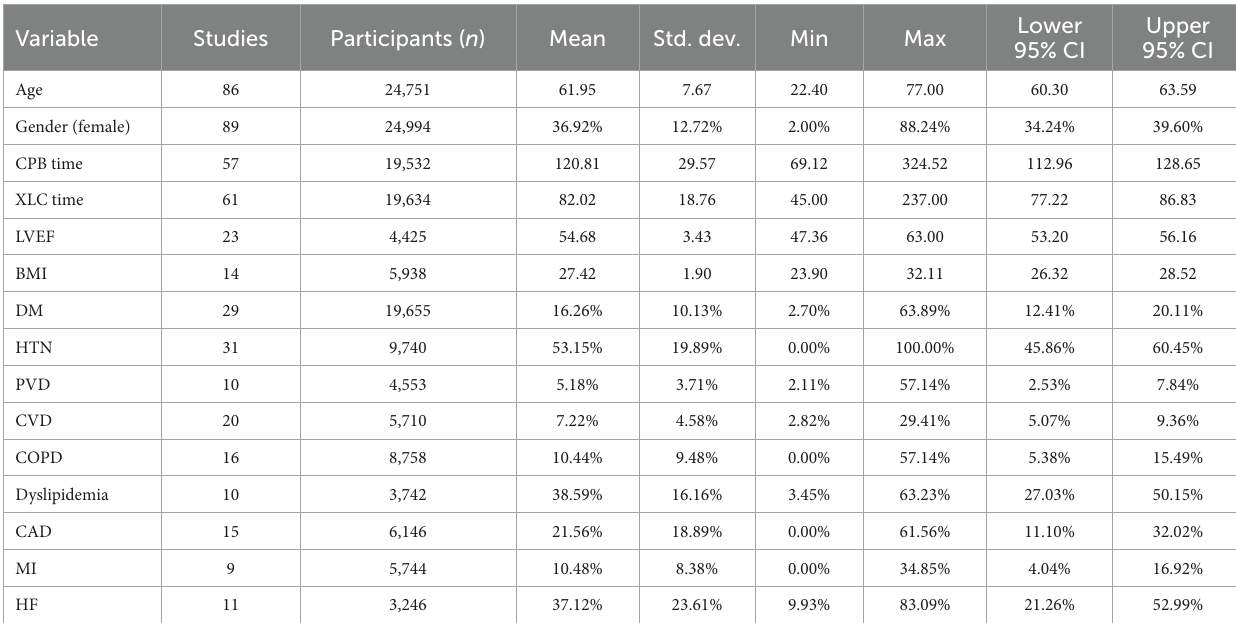
TABLE 3 Summary of baseline patient characteristics in included